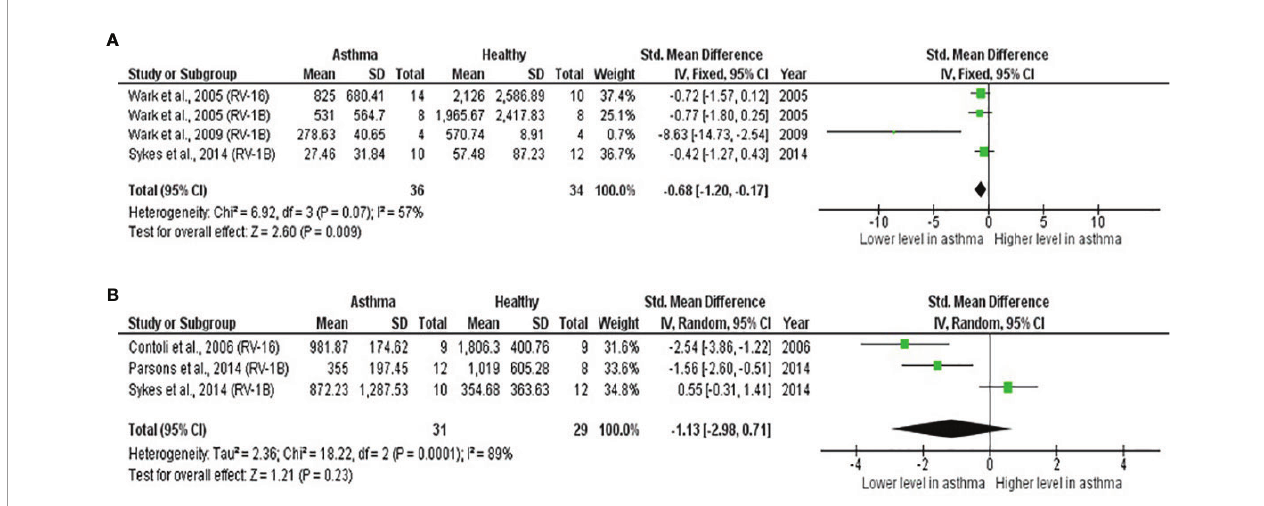
( Figure 6A ). Publication bias was unclear due to the low number of studies (n = 2).